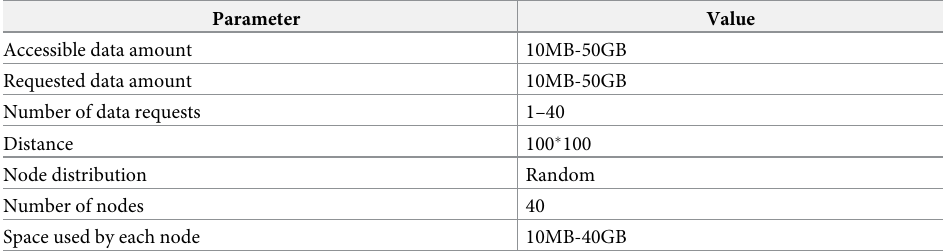
Table 3. Parameter values considered for the proposed